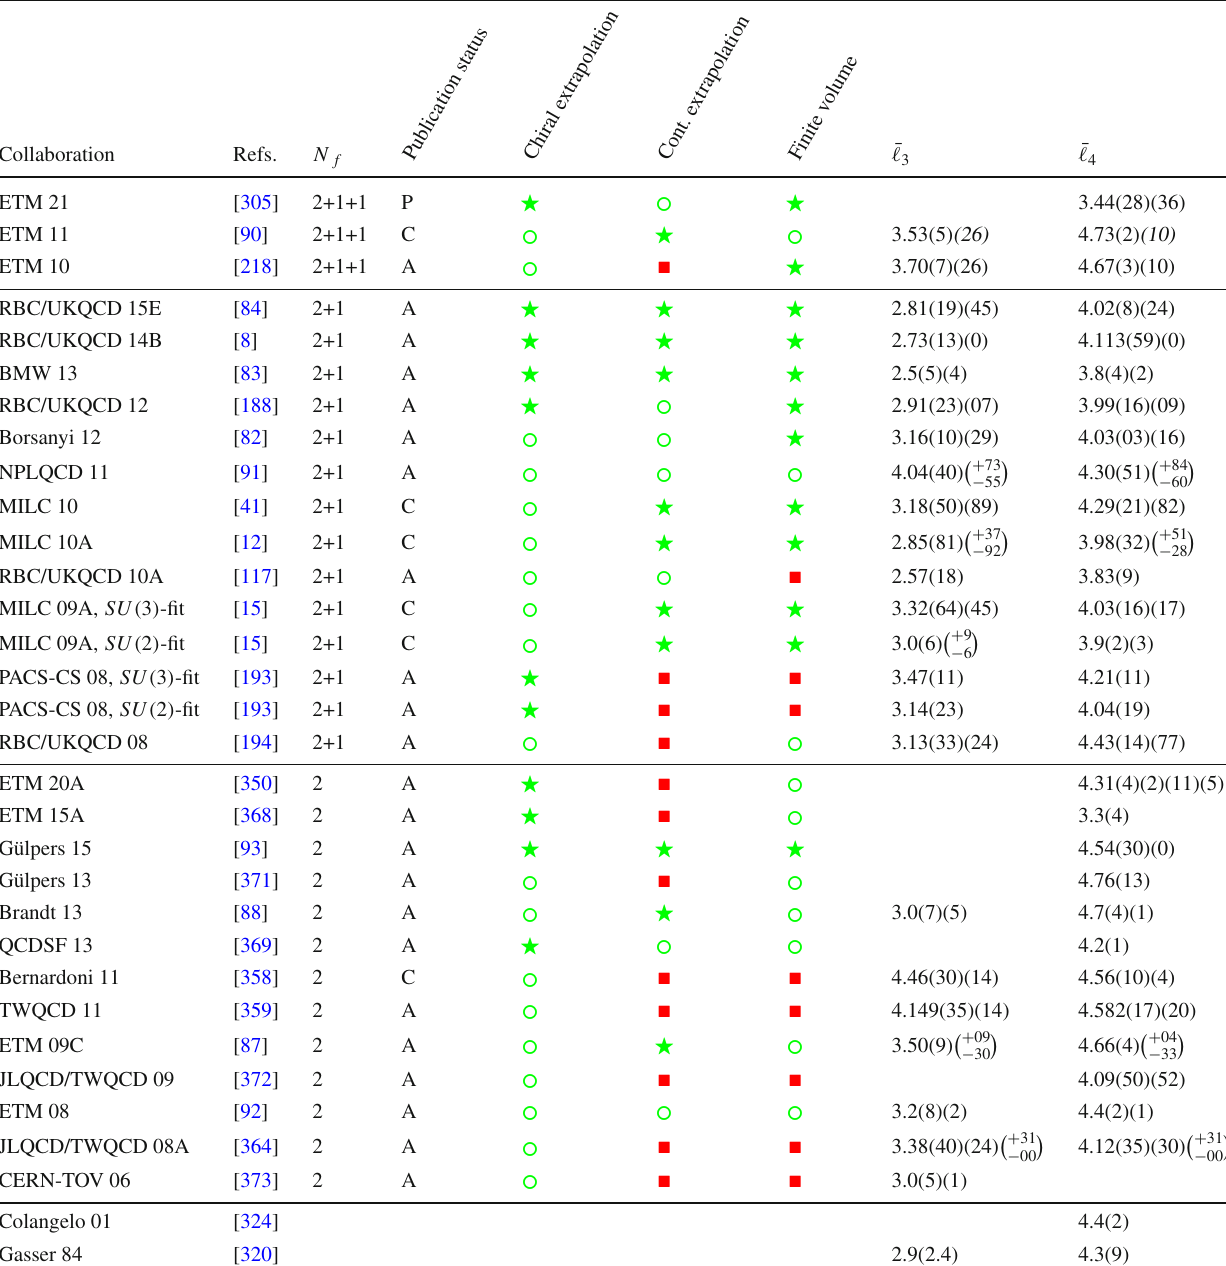
Table 23 Results for the SU ( 2 ) NLO low-energy constants ¯ (cid:6) 3 and ¯ (cid:6) 4 . For comparison, the last two lines show results from phenomenological analyses. The systematic error in ETM 11 has been carried over from ETM 10